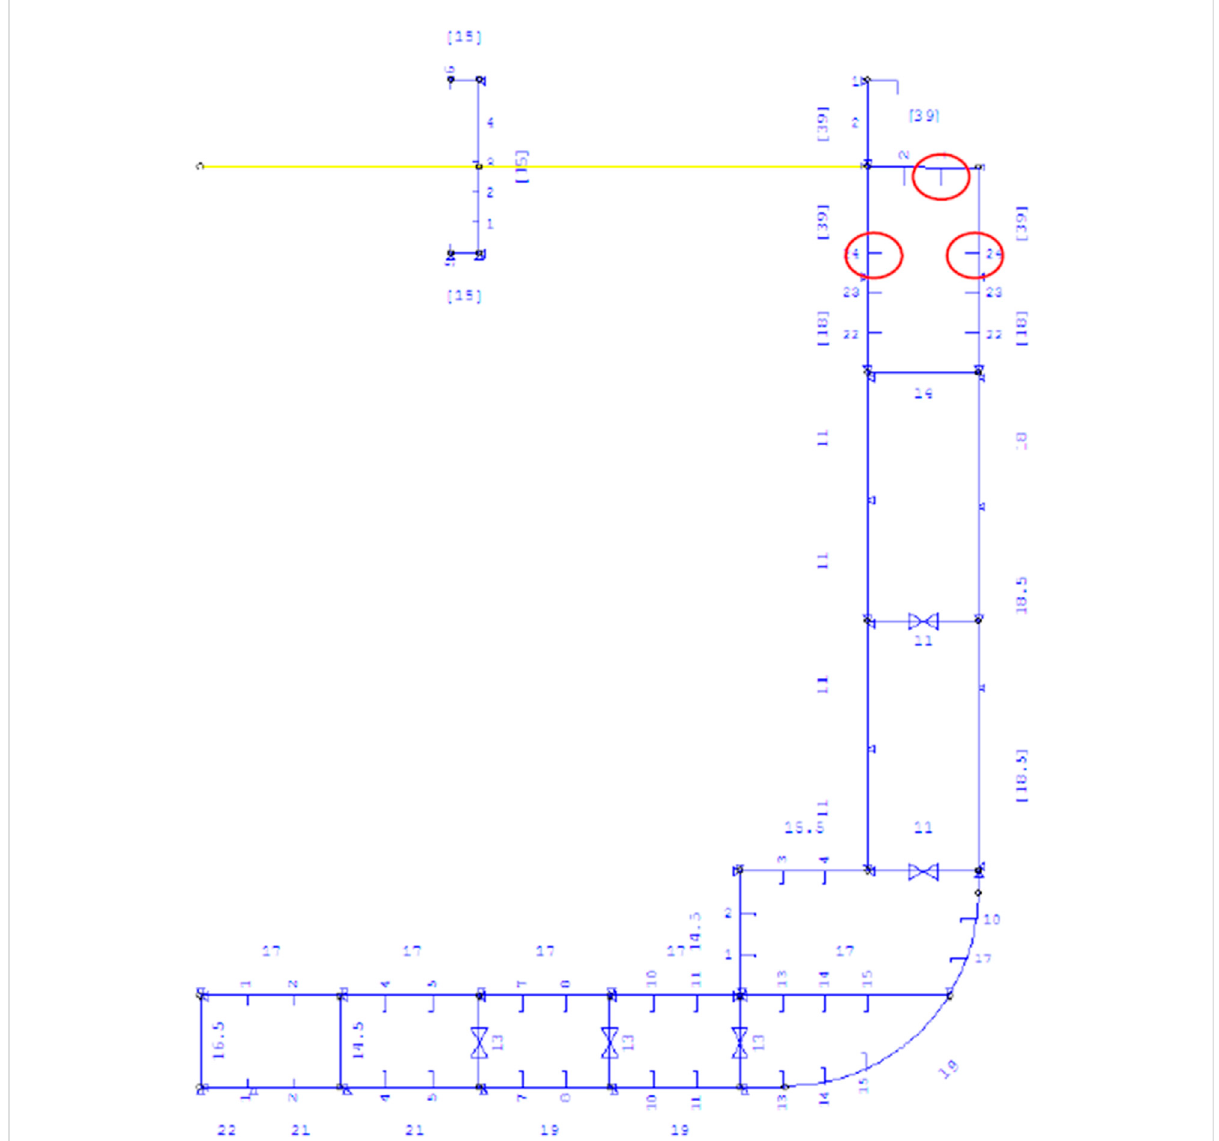
FIGURE 5 Layout of the mid-ship cross-section showing the measurement position in the upper deck and crack positions at stringer level 1 (Gaidai et al.,